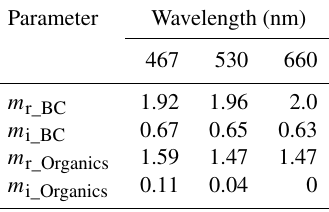
Table 1. Refractive indices ( m r and m i ) of BC and organics at vari- ous wavelengths in the visible range (Kim et al., 2015) used in this